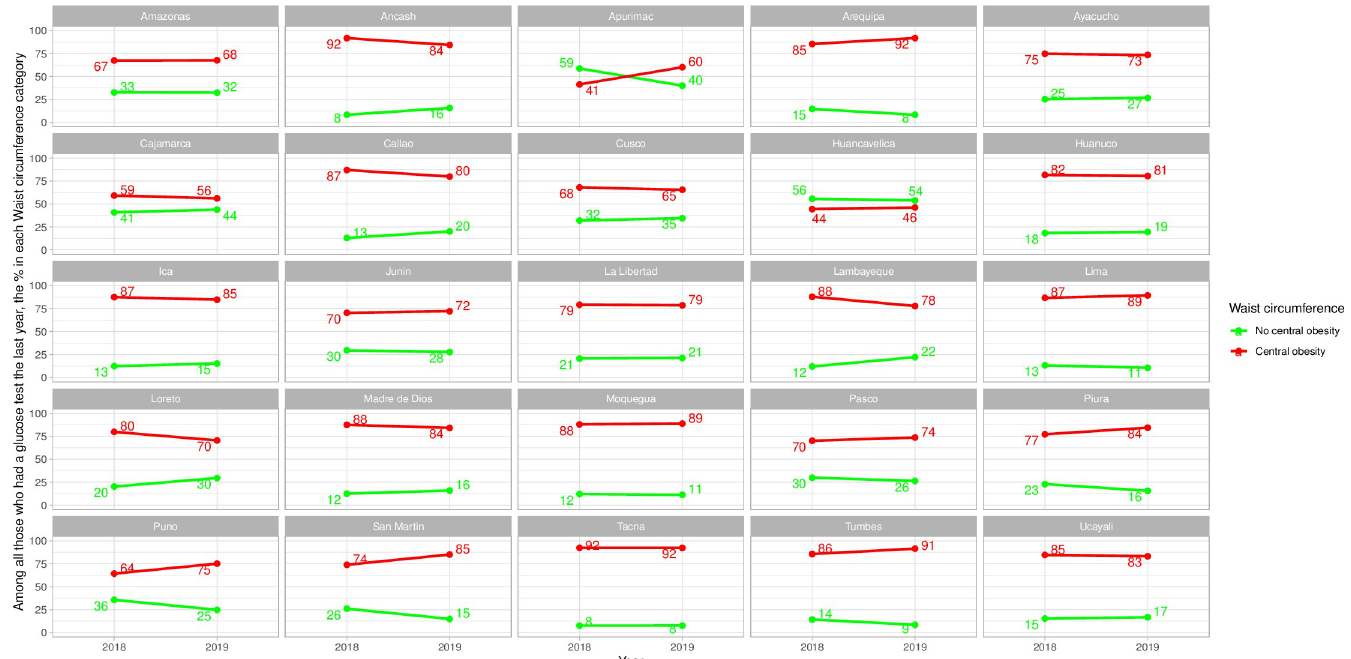
Fig 5. Sub-national time trends of glucose test by waist circumference categories in men.